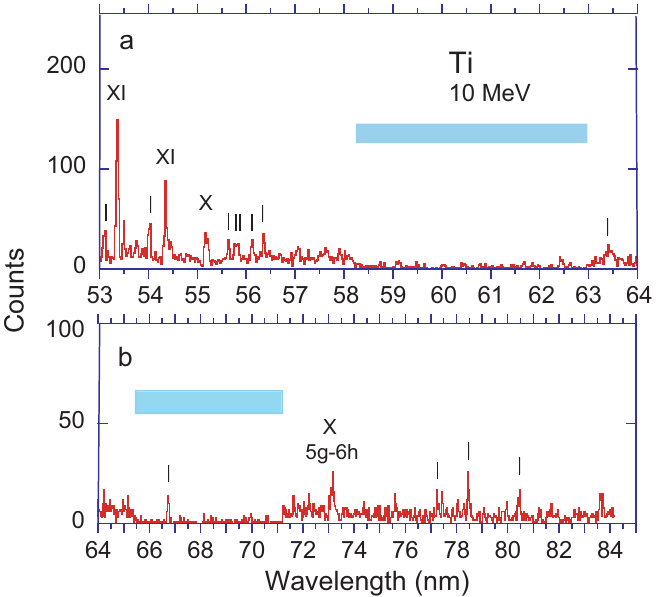
Figure 8. Continuations of the Ti spectrum recorded at an ion beam energy of 10 MeV. ( a ) continues Figure 7b, ( b ) continues Figure